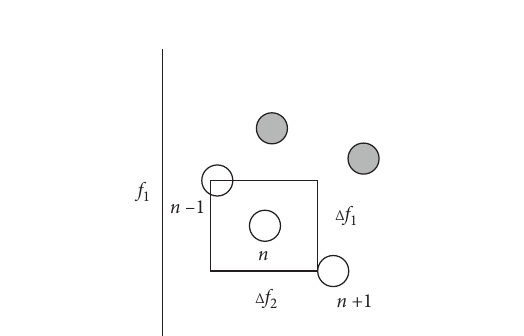
Figure 3: Chromosome decoding.